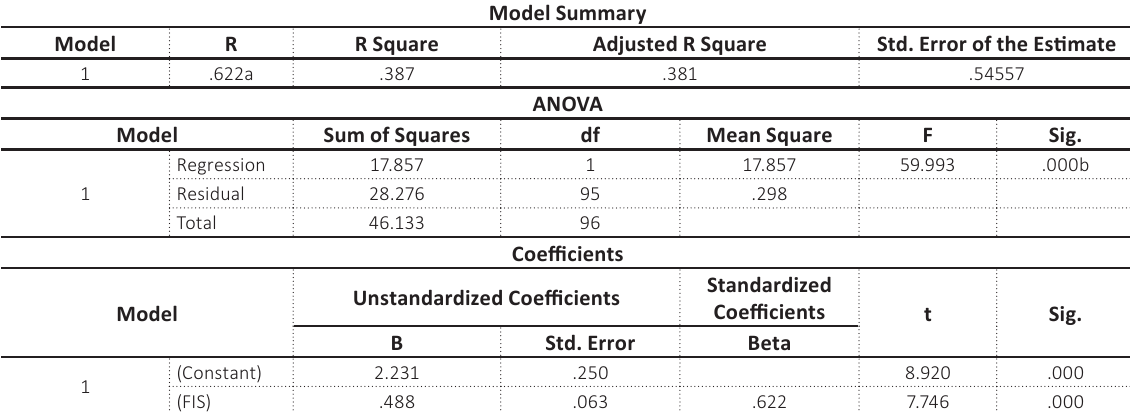
Table 5. Testing the 1st hypothesis